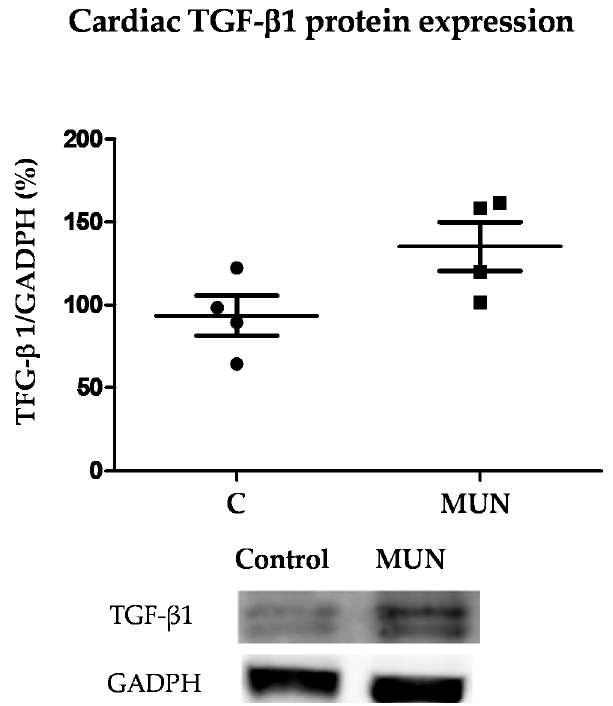
Figure 6. Protein expression level of TGF- β 1 by Western blot in cardiac tissue from 21-day old male rats. Results show the densitometric analysis, relativized to GADPH expression and representative examples. Sample size per group: 5–7 rats from 4 litters. Student’s t test.